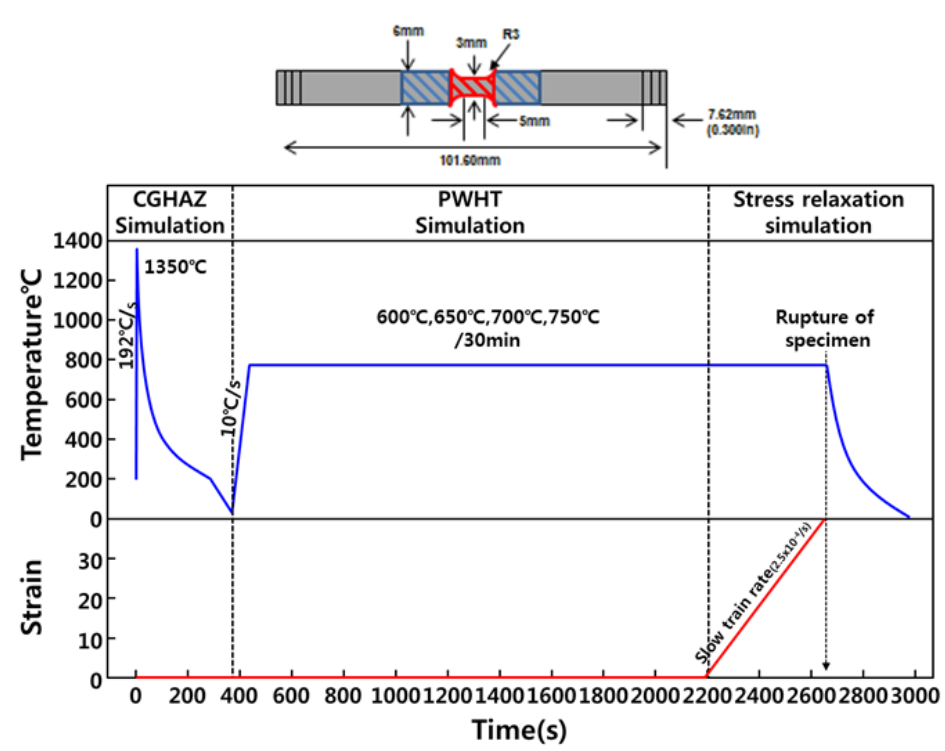
Figure 1. Schematic illustration of a post-weld heat treatment (PWHT) cracking susceptibility test at various PWHT temperatures, and the geometry of the sample.